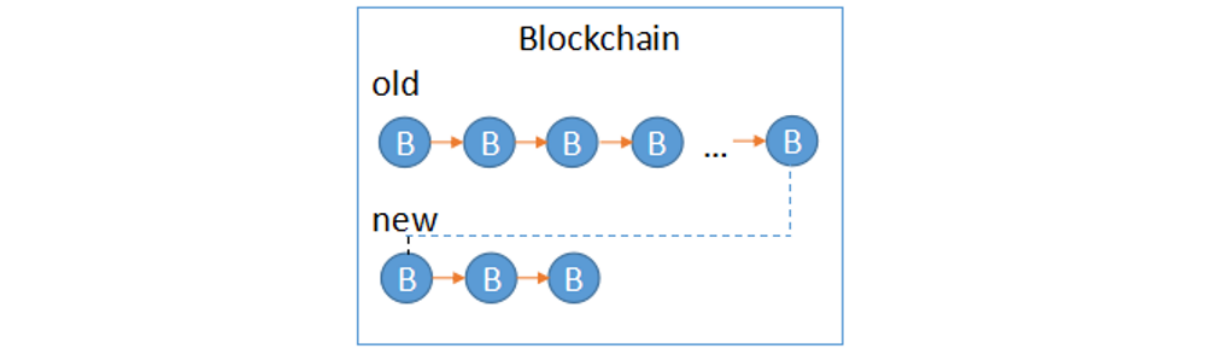
Figure 3. Vertical blockchain